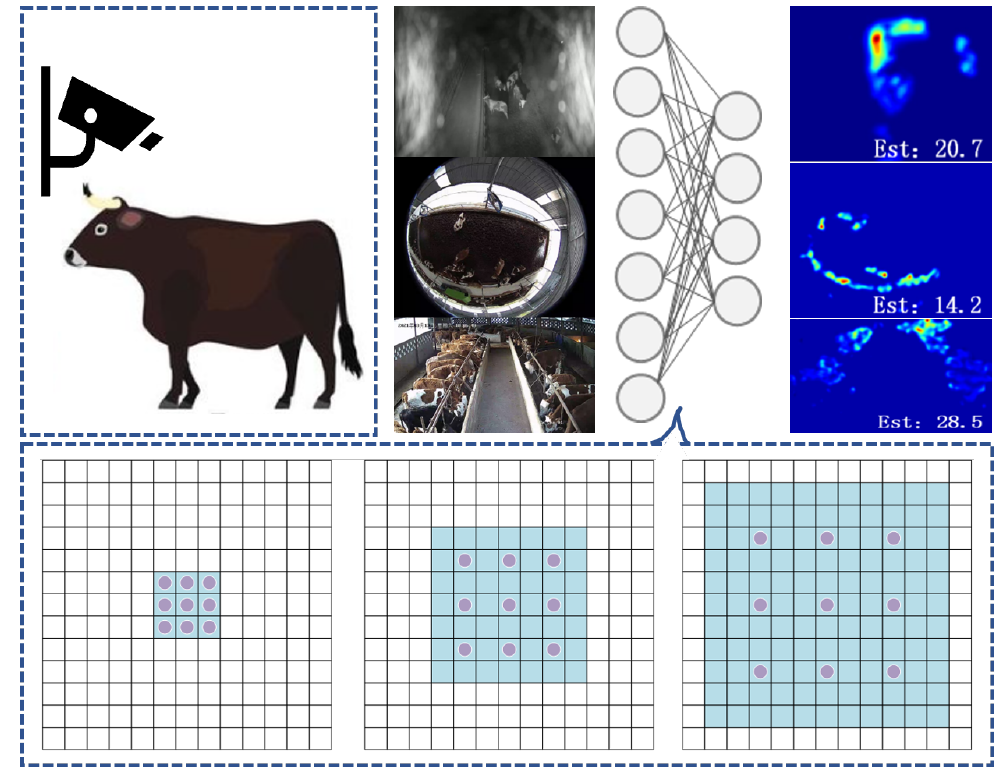
Figure 1. Given a conceptual description from data collection to model training, in which the module obtains multi-scale receptive fields by using multi-column dilated convolution to handle the problem of scale variations of